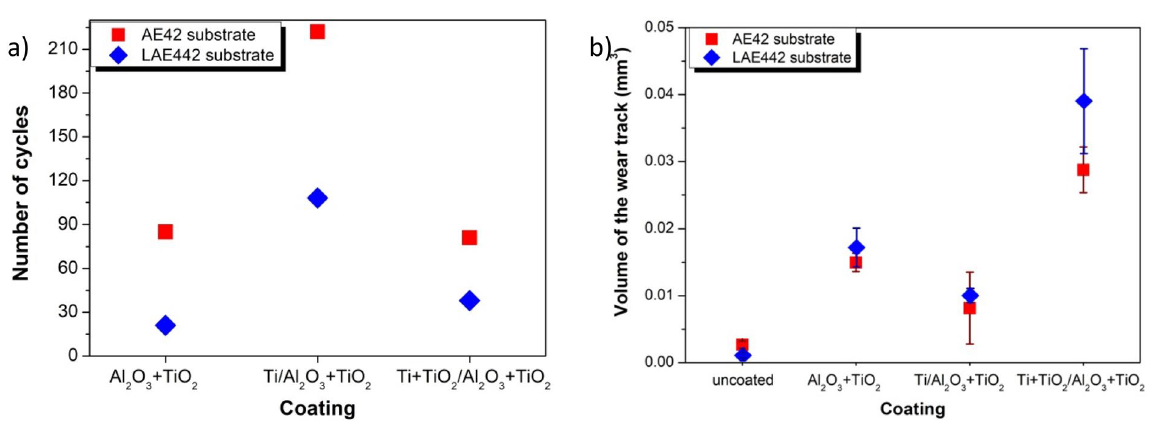
Figure 18. Comparison of the results of tribological tests of the investigated coatings on magnesium alloys: ( a ) the critical number of cycles, ( b ) the volume of the wear